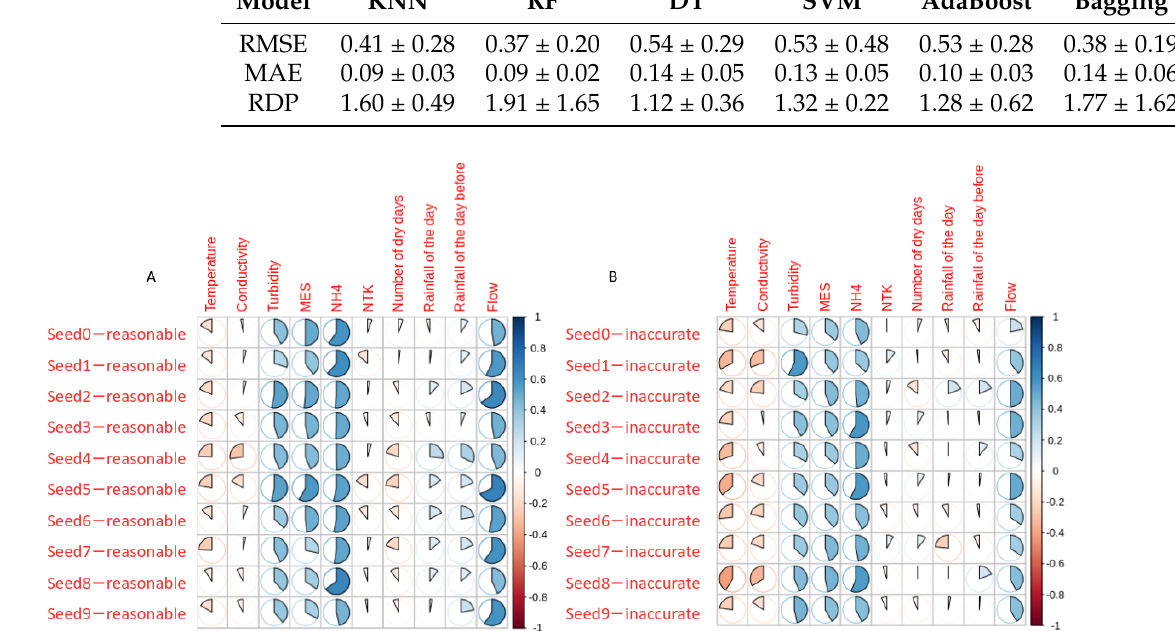
Figure A1. Correlation analysis between water quality parameters and E. coli concentration estimated by RF for ( A ) reasonable estimation and ( B ) inaccurate estimation of E. coli ( n =